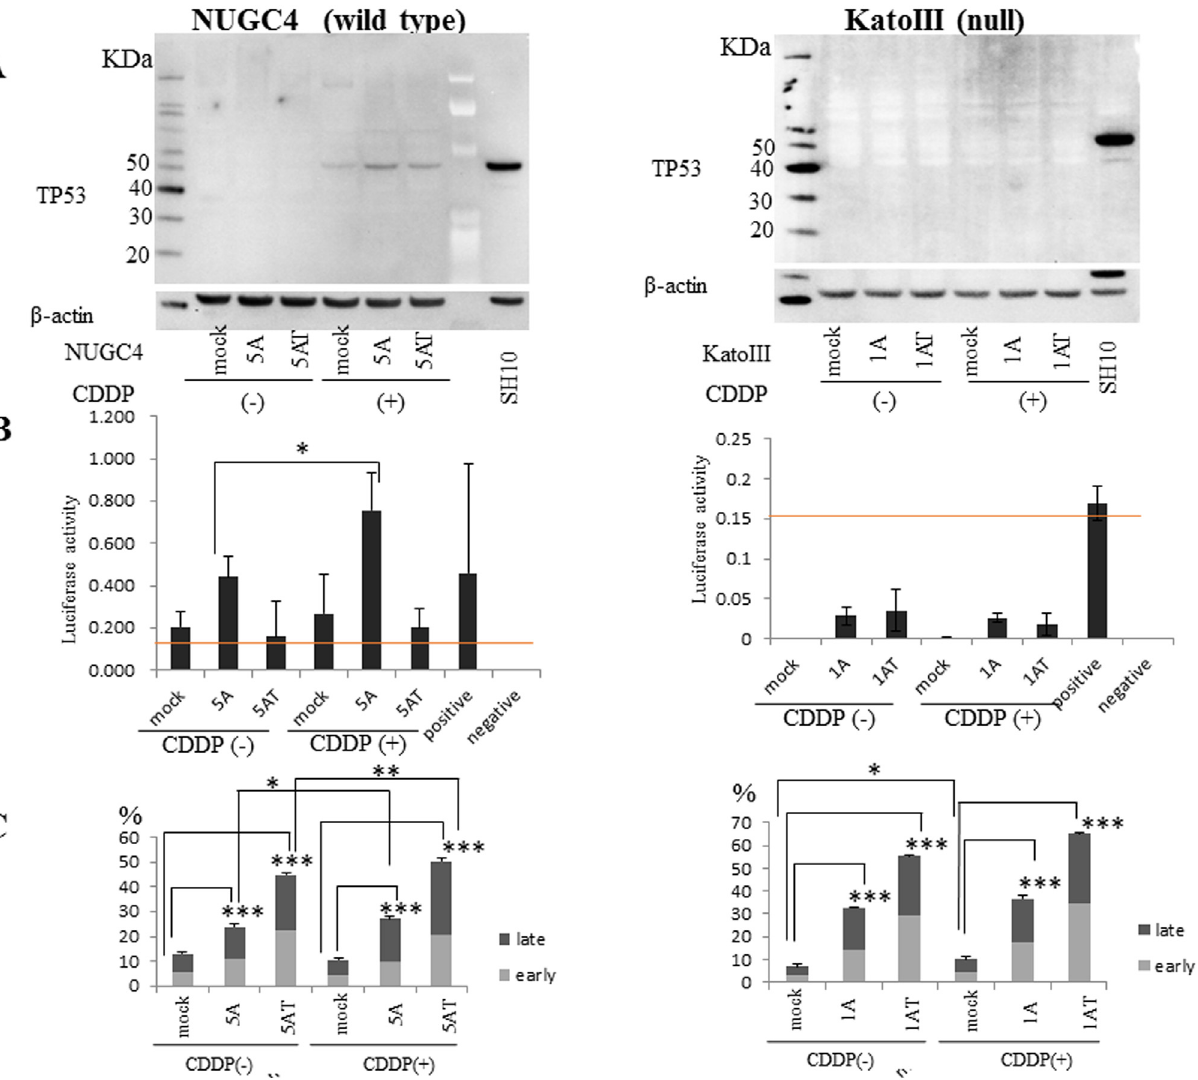
Fig 6. Epigenetic and/or chemotherapeutic treatments of the NUGC4 (wild type p53 ) and KATOIII ( p53 null) gastric cancer cell lines. NUGC4 and KATOIII cells were treated with the demethylating agent, 5-aza-2 ’ -deoxycytidine (5-aza-dC) in the presence or absence of the histone deacetylase (HDAC) inhibitor, trichostatin A (TSA), and in the presence or absence of the chemotherapeutic reagent, CDDP. 1A and 5A, 1 and 5 μ M 5-aza-dC; T, TSA. Subsequently the cells were analyzed for: (A) p53 protein expression by Western Blotting. (B) A dual reporter assay to confirm p53 transcription activity. The dashed line indicates the optimal cut-off value (0.15) for determination of p53 activity. (C) Cell apoptosis was assayed using a Nexin Assay. A representative image is shown. Data are shown as the percentage of early and late apoptotic cells. * P < 0.05, ** < 0.001, *** <